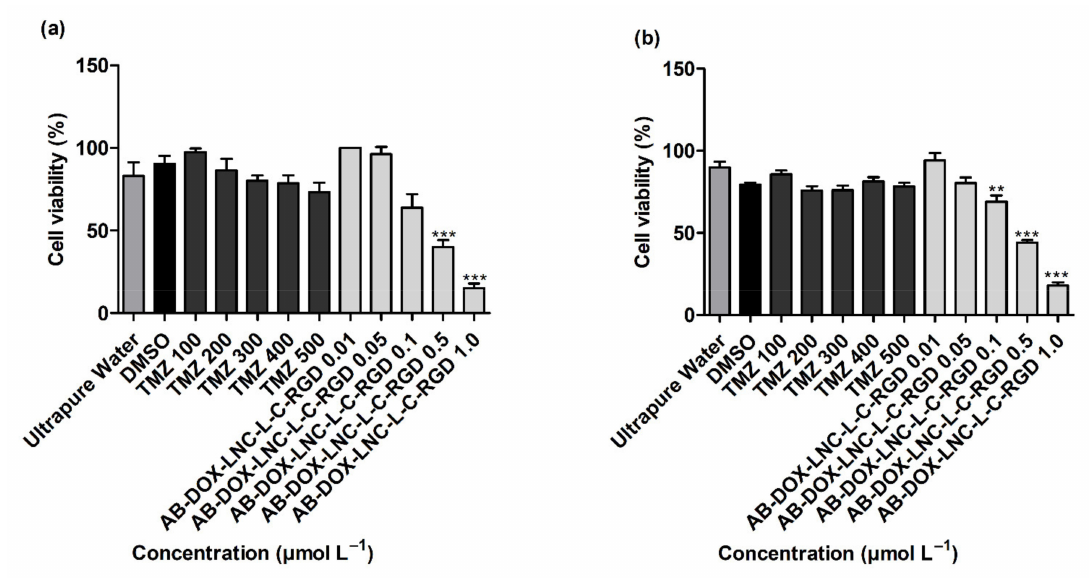
Figure 2. Cell viability evaluation using the MTT assay after 24 h of treatment on ( a ) U87MG cell line, IC 50 = 0.52 ± 0.07 µ mol L − 1 (doxorubicin-equivalent) and ( b ) U138 cell line, IC 50 0.49 ± 0.03 µ mol L − 1 (doxorubicin- equivalent). Ultrapure water (control 2), DMSO (control 3). Data are expressed as the mean ± SEM. ( n = 3) ** represents statistical difference with respect to the control (ultrapure water) ( p < 0.01). *** represent the statistical difference with respect to the control (ultrapure water) ( p < 0.001) (ANOVA,